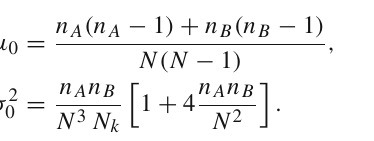
For the comparison of a set of QCD jets with a set con- taining a small fraction f of W jets, we randomly take n elements from P A , n ( 1 − f ) elements from P B 1 and